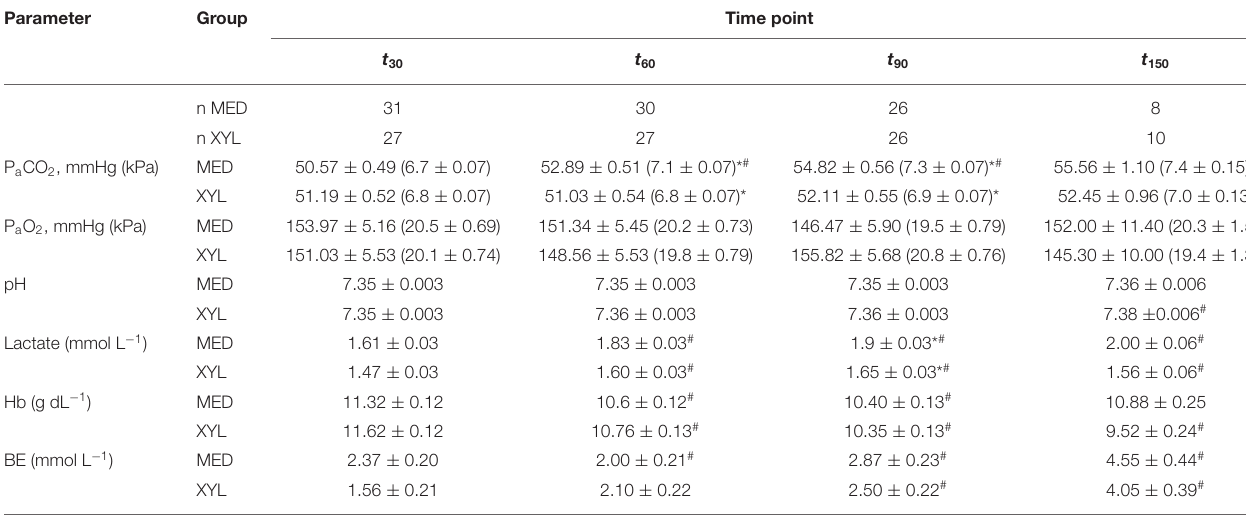
TABLE 2 | Mean ± SEM of arterial blood-gas values, pH, lactate concentrations, total hemoglobin, base excess in horses with medetomidine isoflurane (group MED) or xylazine isoflurane (group XYL) balanced anesthesia.